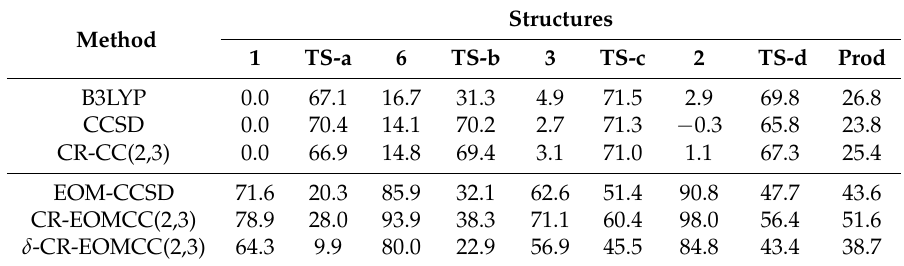
Table 5. Relative energies (above) and excitation energies (below) for the C 2 Si 2 H 4 stationary points appearing in Figure 5. All values are reported in